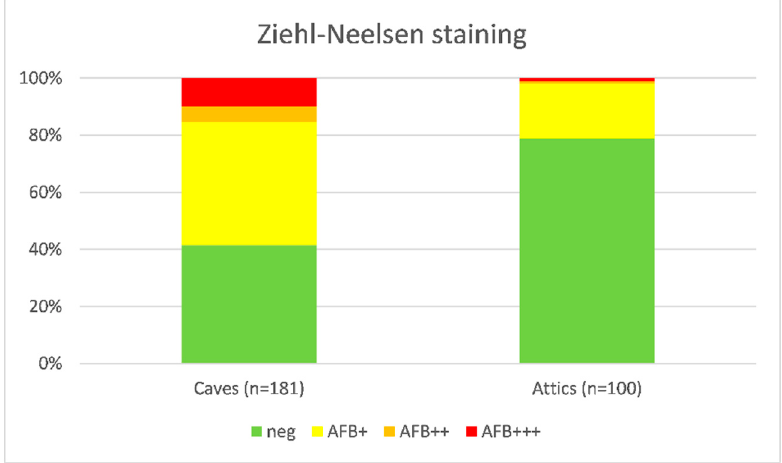
Figure 1. Bat guano origin and ZN microscopy results. Figure interpretation. ZN = microscopy ex- amination after the Ziehl–Neelsen staining in at least 200 fields [43]; negative = negative examination; + sporadic acid-fast bacteria (AFB) detection; ++ = few AFB present in each field; +++ = too numerous to count (TNTC) of AFB in each field.